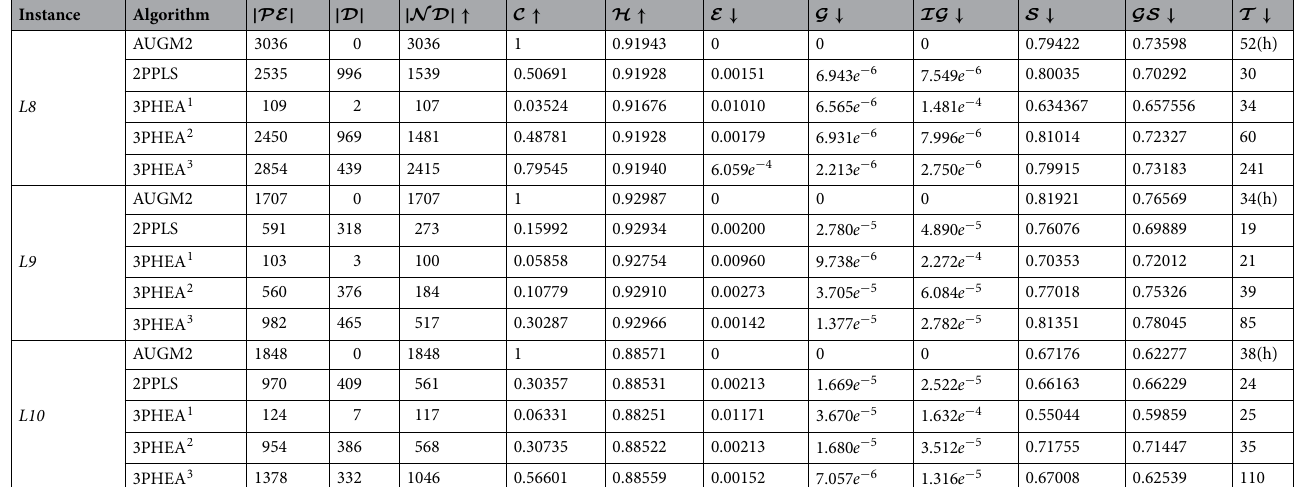
Table 5. Experimental results for datasets (Lust and Teghem 41 ). | PE | : Number of potentially efficient solutions; | D | : Number of dominated solutions; | ND | : Number of nondominated solutions; C : Coverage metric; H : Hypervolume; E : Epsilon indicator; G : Generational distance; IG : Inverted generational distance; S : Spread; GS : Generalized Spread; T : Time in seconds unless